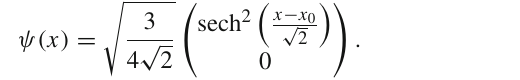
depict the fermionic threshold energies in the background model. Right graph : the derivative of the fermionic negative bound energy with respect to φ 0 as a function of φ